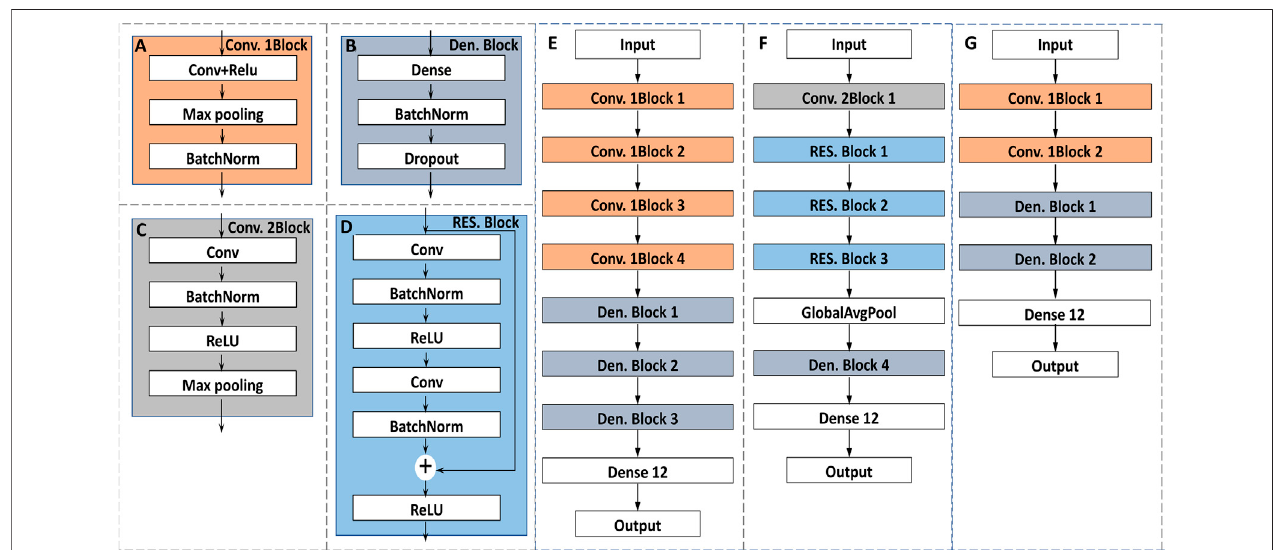
FIGURE3| Thearchitecturesoftheproposedclassi fi cationmodels: (A) thearchitecture oftheConvolution1Block; (B) thearchitectureoftheDenseBlock; (C) the architecture of the Convolution 2Block; (D) the architecture of the Residual Block; (E) the architecture of the 1D-CNN1; (F) the architecture of the 1D-CNN2; (G) the architecture of the